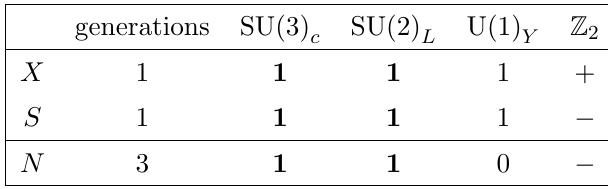
Table 6 . New particles in the KNT model with respect to the